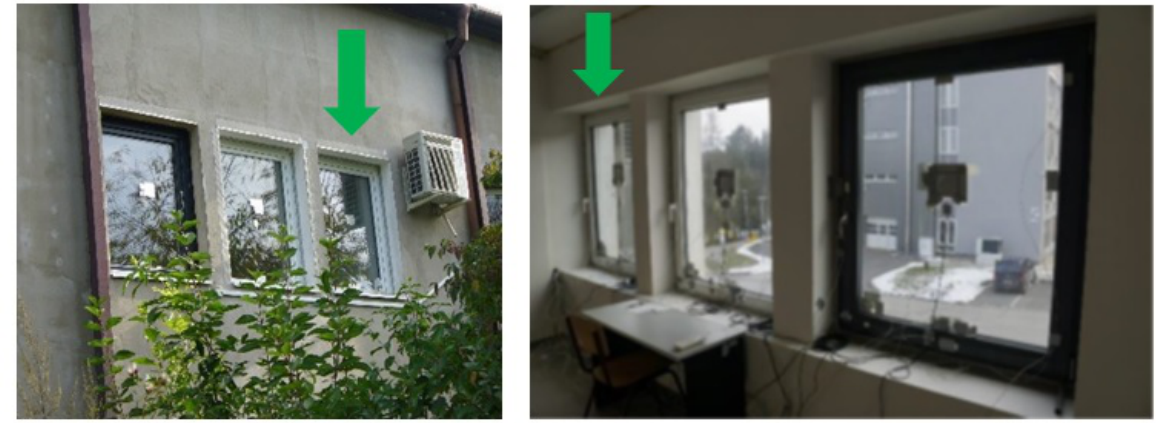
Figure 1. External and internal view of the built-in plastic window in the test laboratory.